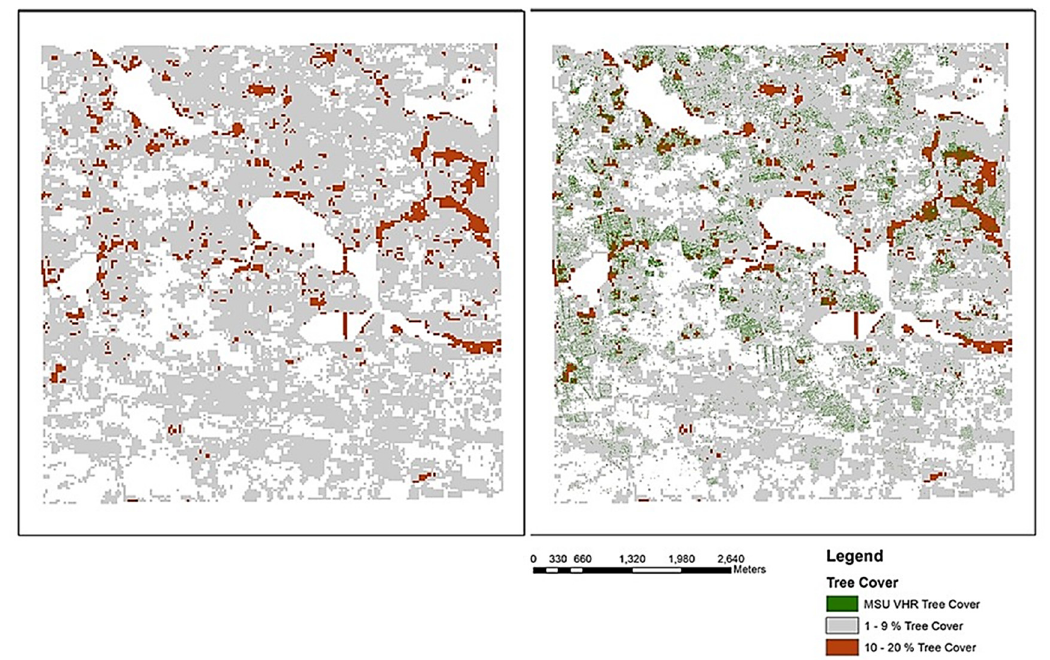
Figure 12. Tree cover from Landsat data for the landscapes in our study area from Hansen et al. ( left ) and with trees from this study overlaid ( right ). Individual trees from the present study are shown in green.